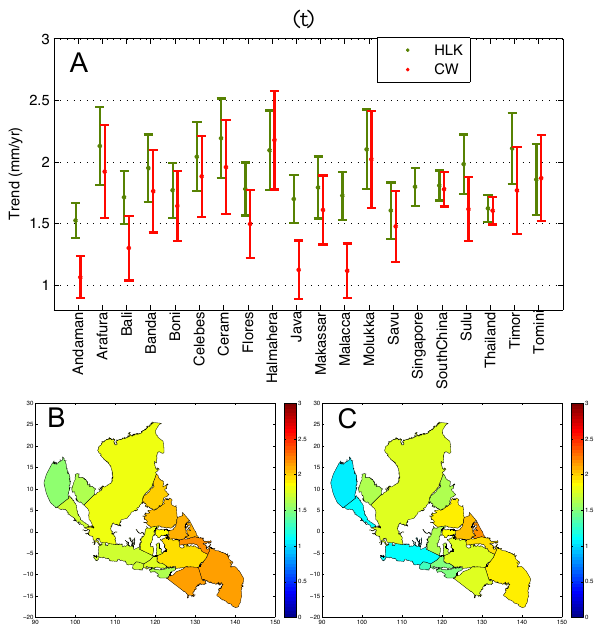
Figure 8. Southeast Asian sea average sea level trends over the 60- year time period from 1950 through 2009 shown plotted as trend values with standard error (a) and as color maps for the HLK re- construction (b) and the CW reconstruction (c) .